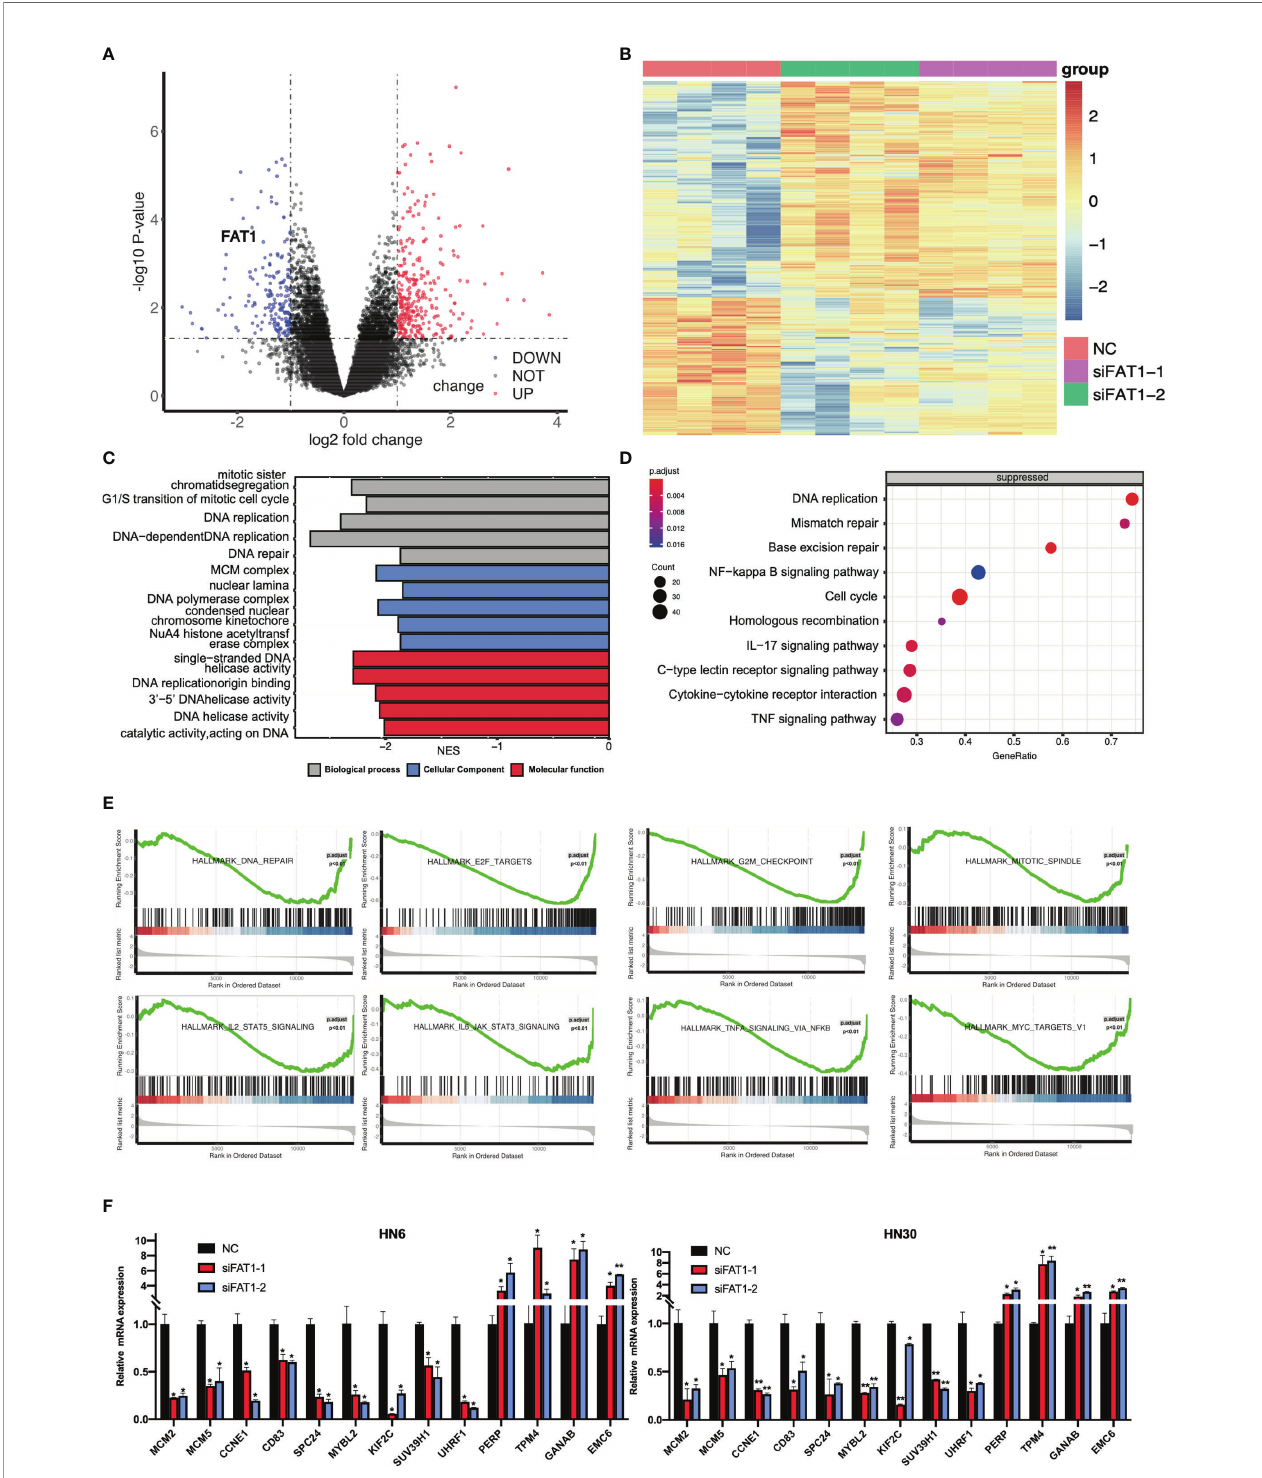
FIGURE 6 | Results of the RNA sequencing analysis and validation of DEGs. (A) Volcano plots of the data from RNA-seq analysis by the Limma-voom R package, presenting the differences between NC and FAT1-KD groups and plotting the log2(fold change) versus the – log10(adjusted P-value). 472 differentially expressed genes (DEGs) were con fi rmed, comprising 289 upregulated (red dots) and 183 downregulated (blue dots) using the thresholds P<0.05 and abs (log2 fold change)>1. (B) Heat map of the DEGs. (C) Suppressed enriched GO terms (BP, CC, and MF). (D) Suppressed enriched KEGG terms. (E) Gene set enrichment analysis (GSEA) plots of the major enriched hallmark pathway. (F) Validation of DEGs of RNA-seq results through quantitative PCR. *P < 0.05; **P <